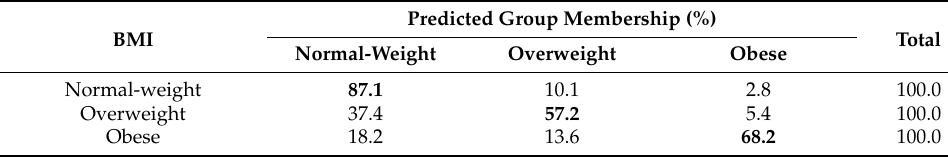
Table 3. Classification results based on discriminant analysis.